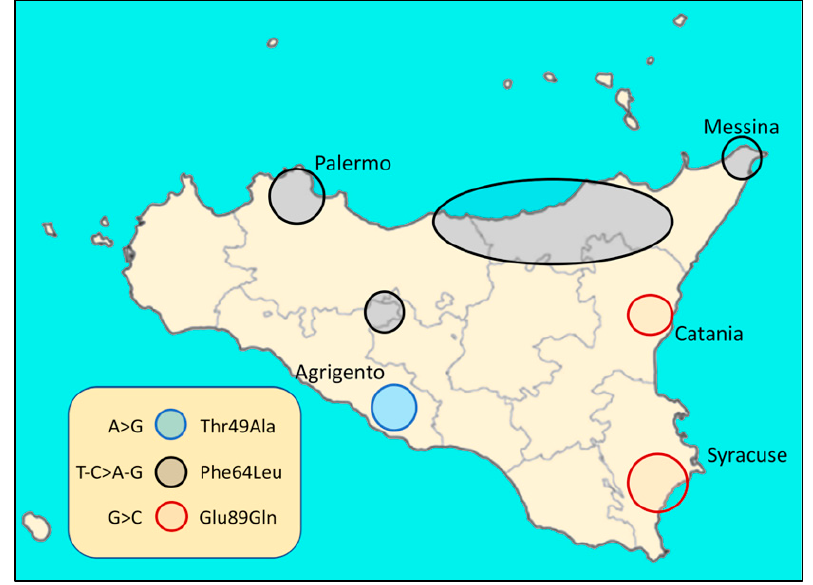
Figure 2. Distribution in Sicily (Italy) of the three endemic TTR variants related to FAP.